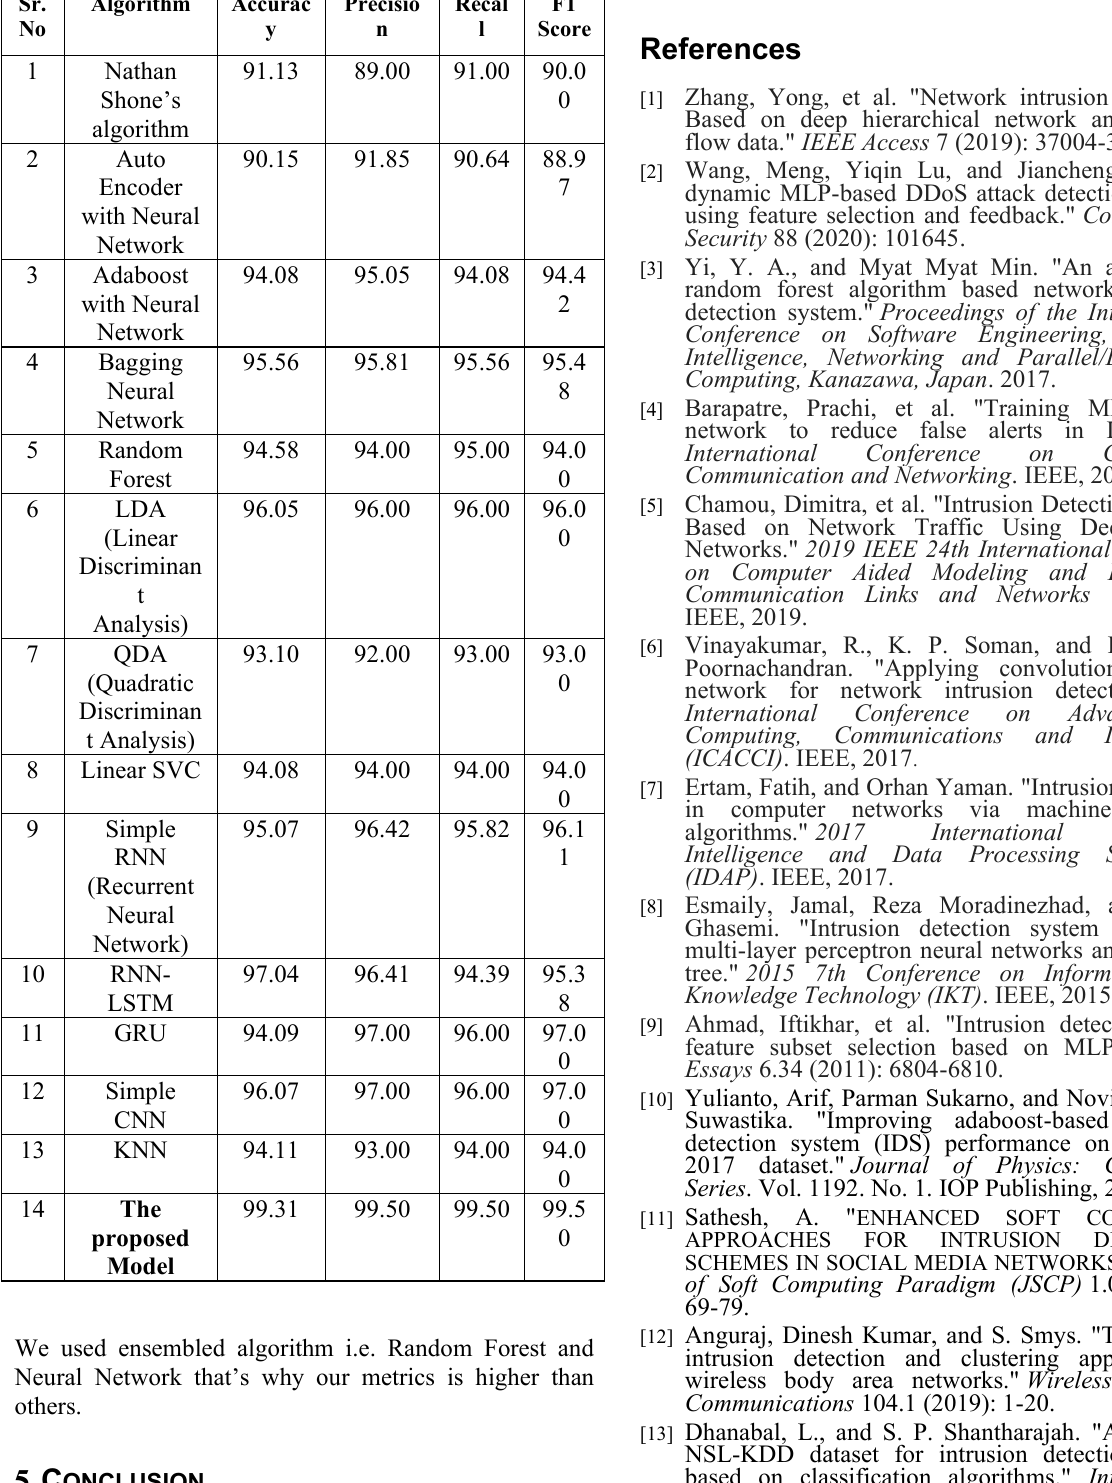
TABLE I. 3-layer MLP Metrics